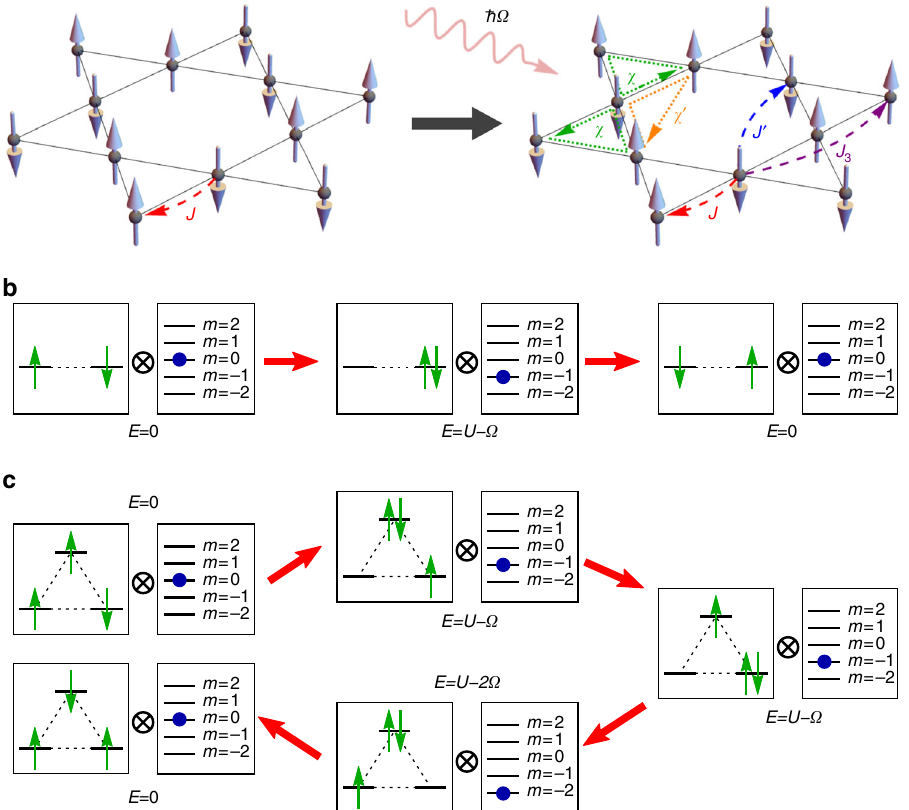
Fig. 1 Photo-induced Kagome chiral antiferromagnet. a Starting from a Kagome Mott antiferromagnet, pumping with circularly polarized light dynamically breaks time-reversal and parity while preserving SU(2) spin symmetry, photo-inducing scalar spin chirality S i · ( S j × S k ) contributions on elementary equilateral ( χ ) and isosceles ( χ ′ ) triangles. Pump strength and frequency provide knobs to tune χ , χ ′ as well as Heisenberg exchange J , J ′ , J 3 , as described in the main text. Examples of b nearest-neighbor and c three-site Floquet virtual hopping processes including absorption of photons, in the Mott-insulating regime. Boxes graphically depict the example initial, virtual intermediate and fi nal states for second- and fourth-order virtual hopping processes, in terms of the product space of electronic degrees of freedom and the Floquet index. TRS is broken in c , inducing scalar spin chiralities χ on triangles of the lattice, whereas b solely induces nearest-neighbor Heisenberg